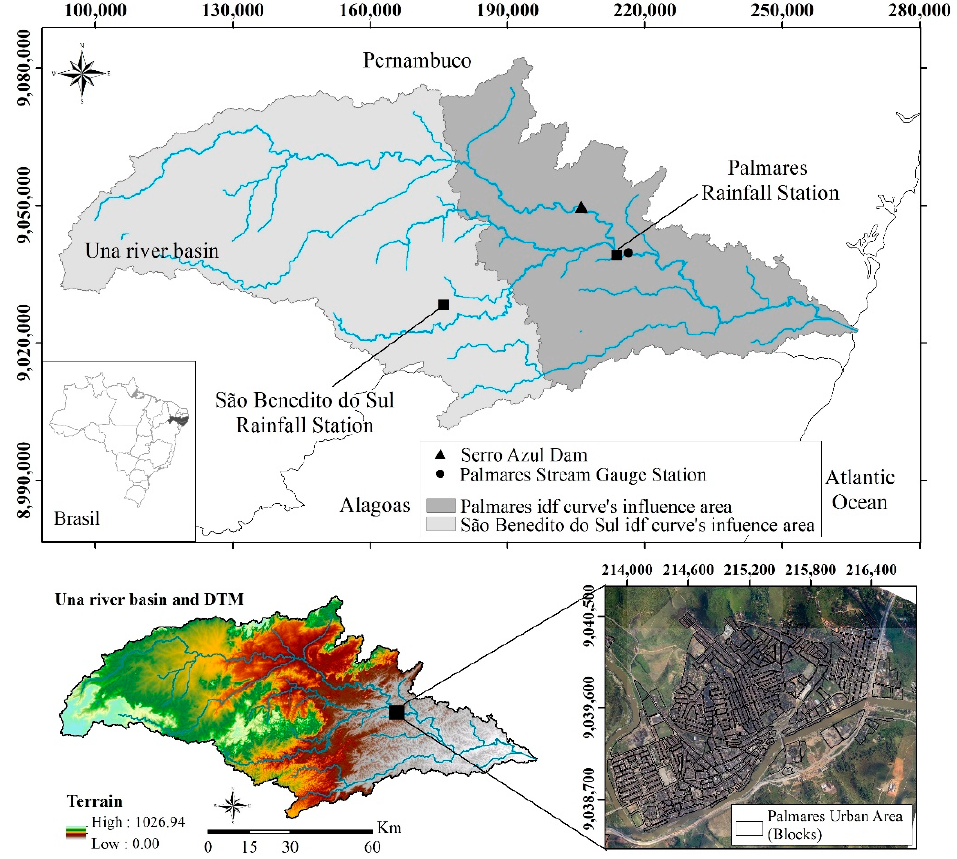
Figure 1. Una river basin location map.